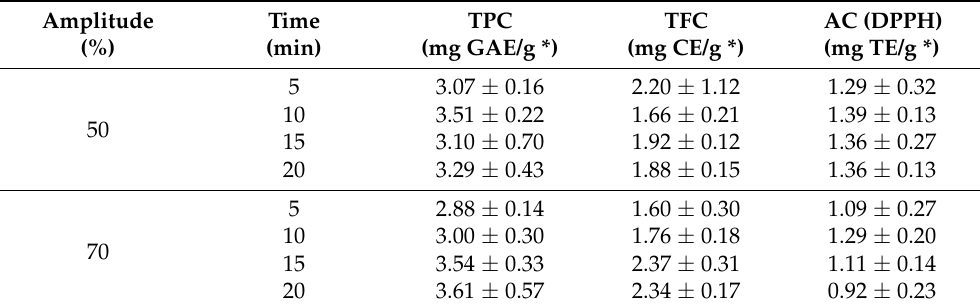
Table 1. Content of phenolic compounds (TPC), total flavonoids (TFC) and antioxidant capacity (using DPPH assays) for different extraction times and ultrasound power. Amplitude Time (%)